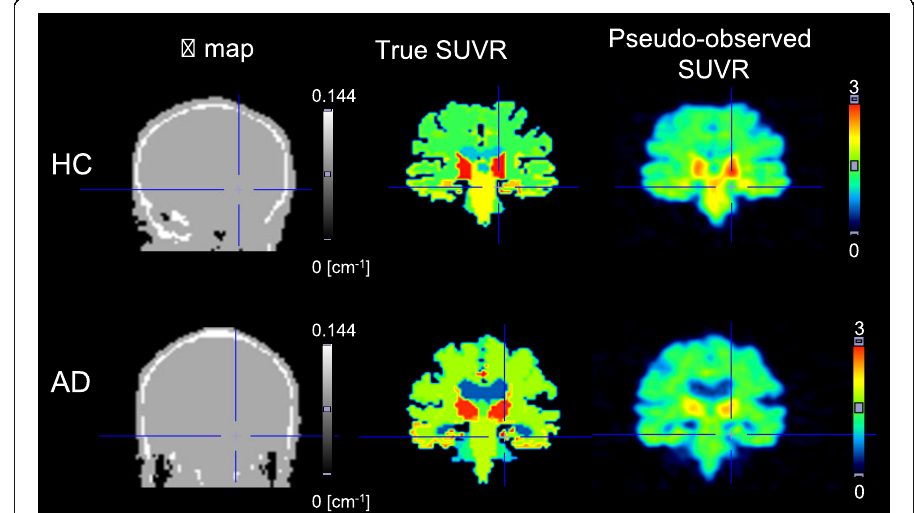
Fig. 2 Simulated images of attenuation-map, true SUVR and pseudo-observed SUVR